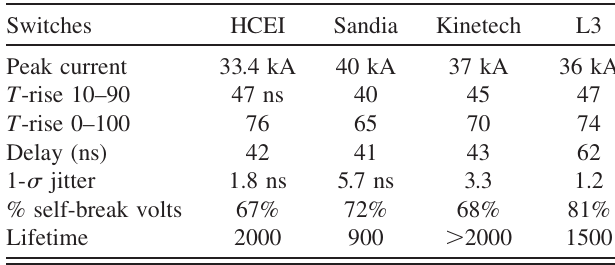
TABLE II. Gas switch matched load operating parameters at (cid:2)